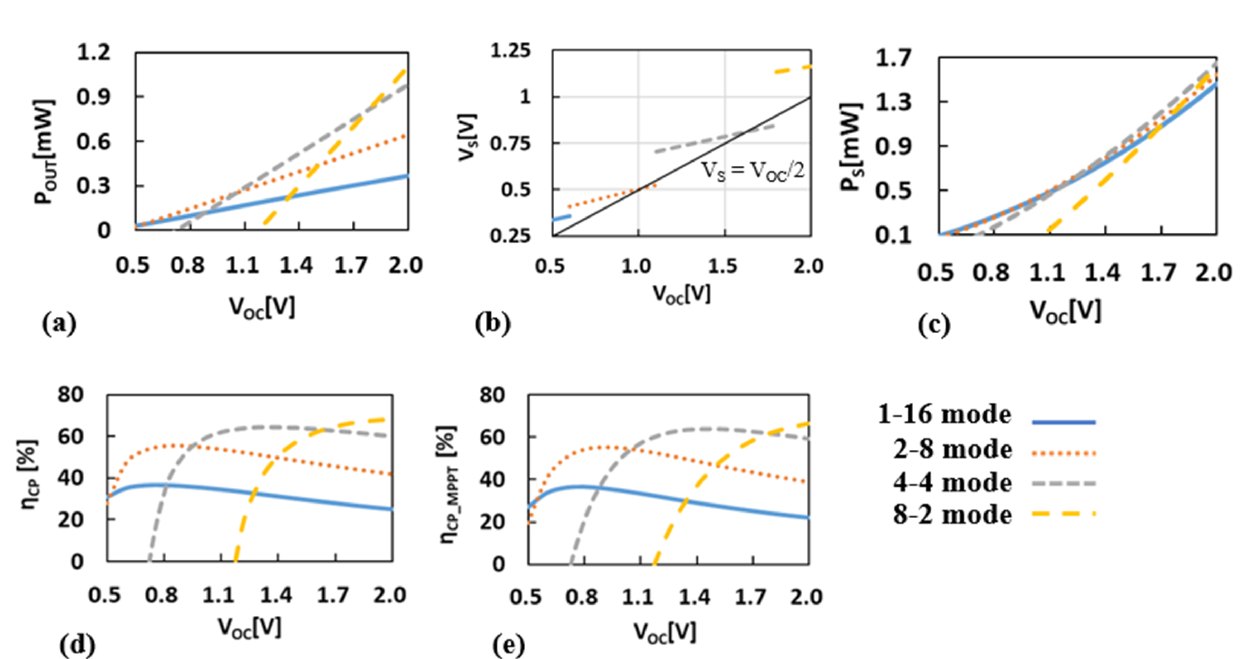
Figure 10. P OUT ( a ), V S ( b ), P S ( c ), η CP ( d ), and η CP_MPPT ( e ) as a function of V OC in different modes. P AV is the maximum attainable power of TEG when the impedance at the interface between TEG and CP is matched, as defined by Equation